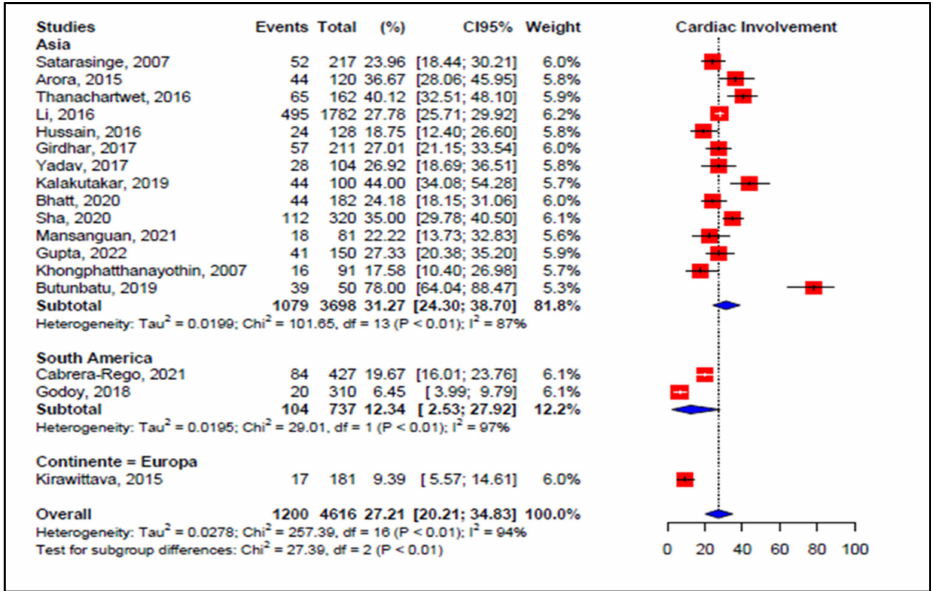
Figure 3. Forest plot comparison of the frequency of cardiac events in patients with dengue, grouped by age group. Legend : CI—confidence interval.